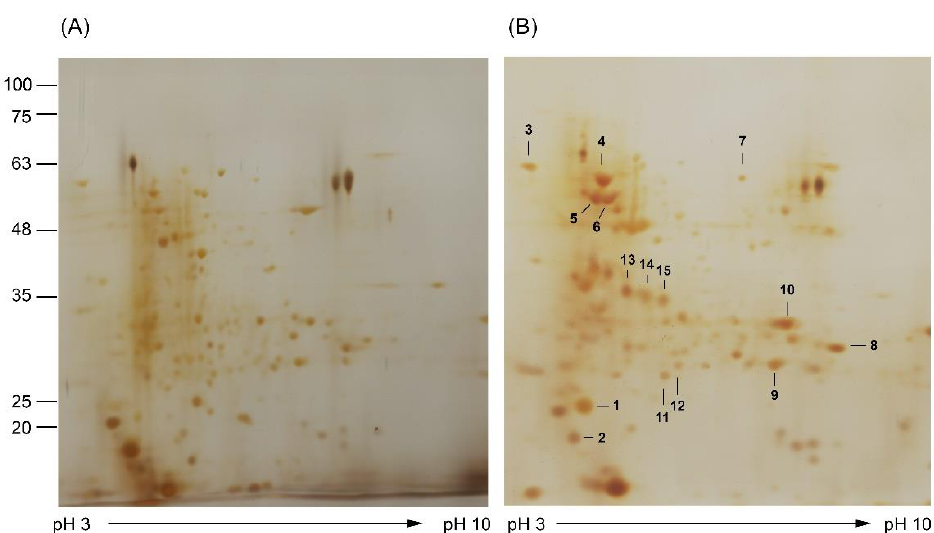
Figure 4. Silver-stained 2D gel images of midgut proteins: ( A ) control group treated with ddH 2 O; ( B ) group treated with concentration at LC 25 of Ag/AgCl NPs synthesized using supernatant of Bti . Numbered spots are differentially expressed proteins that were selected for identification using LC-MS. Positions of molecular size markers (in kDa) are indicated on the left and the pH range of isoelectric focusing on the bottom. Table 3. Identification of differentially regulated proteins between control (ddH 2 O) and Ag/AgCl NP treatment groups. Database searches using the Mascot program against A. aegypti protein data- base.